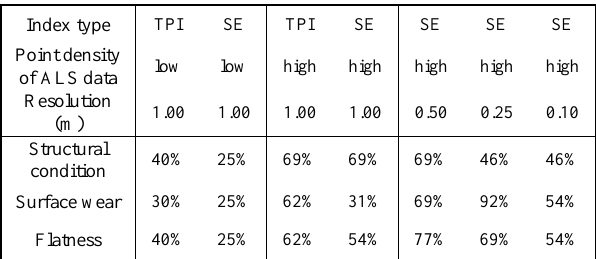
Table 3. Cross-validation of the classification of road